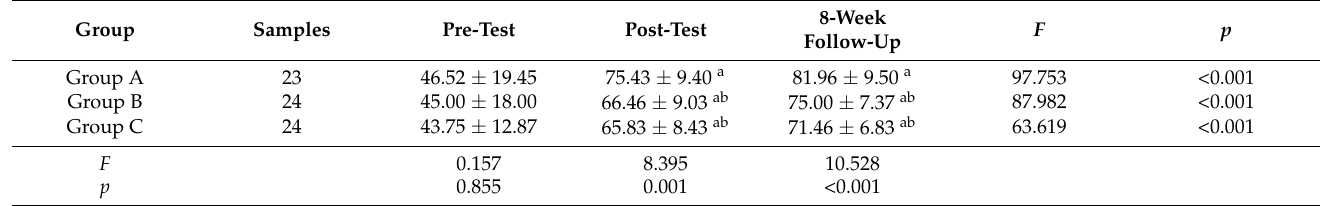
Table 4. MBI scores in A, B, C ground at T 0 , T 1 , T 2 in terms of mean ± standard error